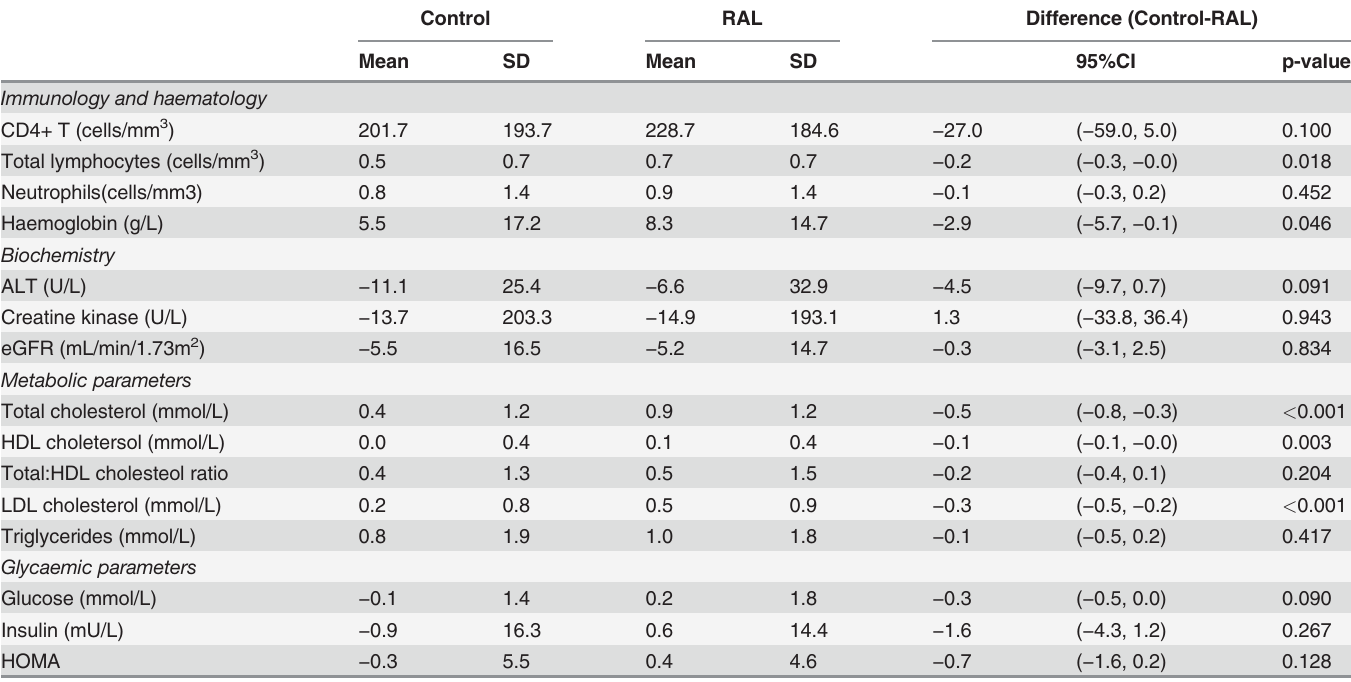
Table 1. Differences in mean change from baseline to Week 96 in laboratory markers by randomised